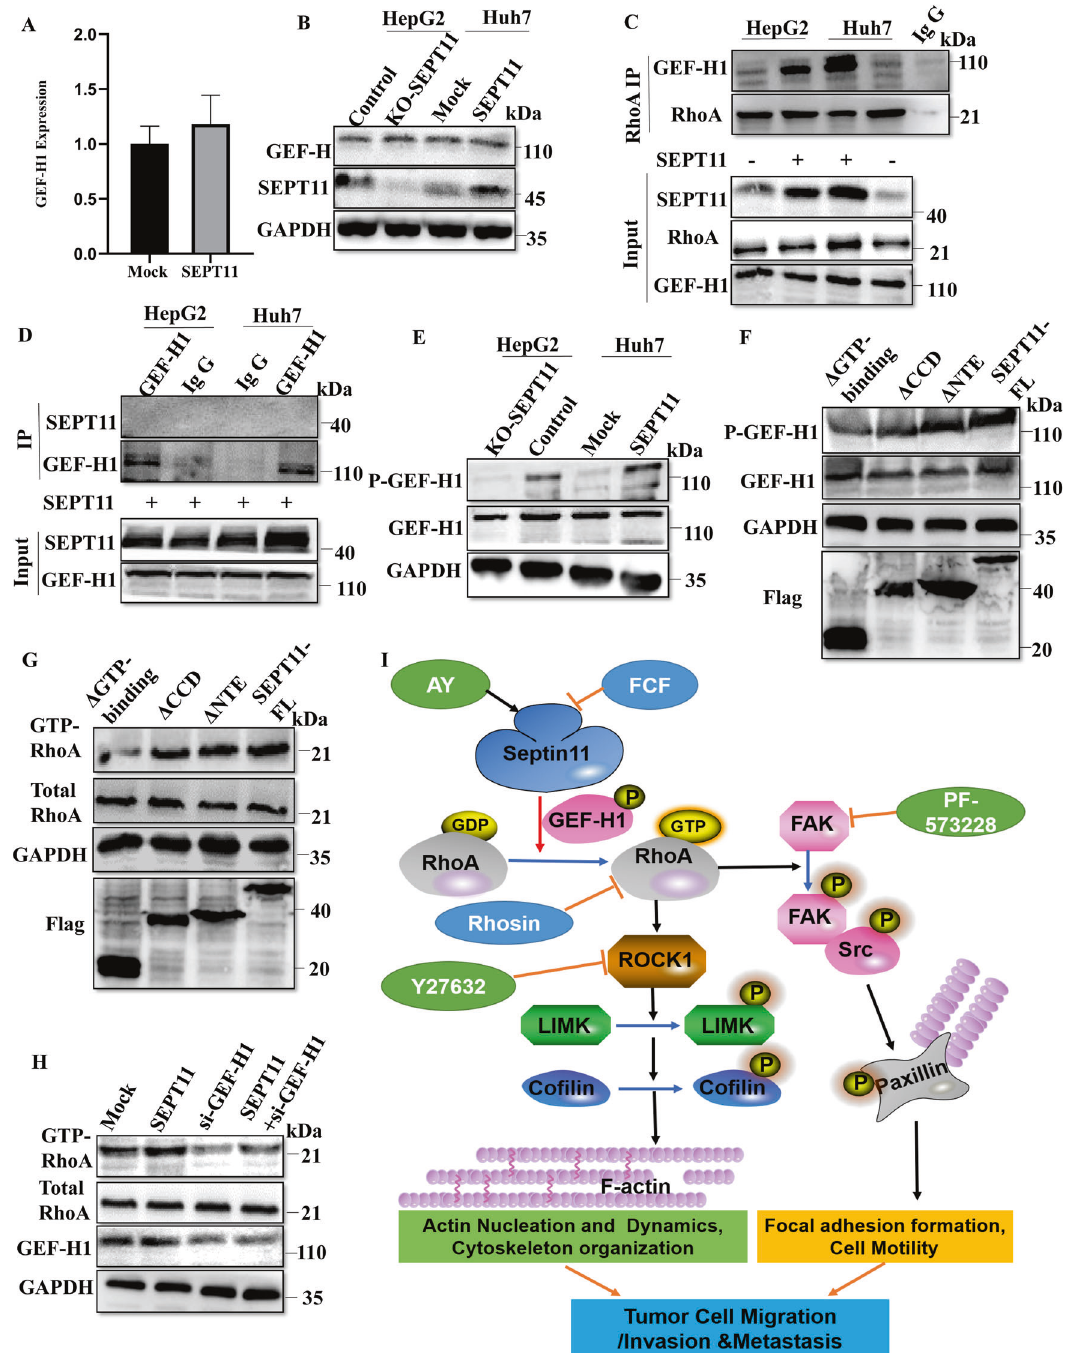
Fig. 7 SEPT11 regulates the activation of RhoA through GEF-H1. A , B QPCR and WB were used to detect the transcriptional expression and protein content of GEF-H1; C CO-IP and WB were used to detect the effect of SEPT11 overexpression on GEF-H1 and RhoA binding; D CO-IP and WB were used to detect the binding of SEPT11 and GEF-H1 in HepG2 and Huh7 cells of SEPT11-overexpressed; E WB was used to detect the in fl uence of SEPT11 on phosphorylation of GEF-H1 Ser886; F WB was used to detect the effect of each structural domain of SEPT11 on Phospho-GEF-H1; G The activation of RhoA promoted by SEPT11 was abolished after removal of the GTP-binding domain; H GEF-H1 can in fl uence the activation of RhoA by SEPT11; I The diagram shows that SEPT11 promotes the activation of RhoA through GEF-H1, then RhoA regulates cytoskeletal organization and FA dynamics by activating LIMK/co fi lin and FAK/Src pathways, thereby promoting the invasion and migration of HCC. results also con fi rm the ability of septins to regulate cell migration expression or knockout of SEPT11 also had little effect on cell and invasion. proliferation-related factors. The result is different from other Given that migratory capability in SEPT11 has been found reported septins to a certain extent, which suggests that there are in vitro and in vivo, the mechanism of SEPT11 in HCC cells had some differences in the function of diverse septins, but these